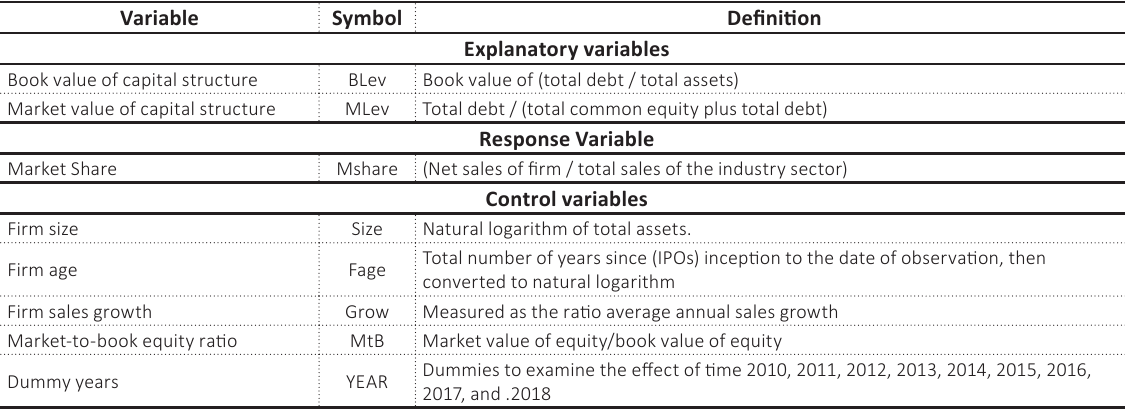
Table 1. Variable